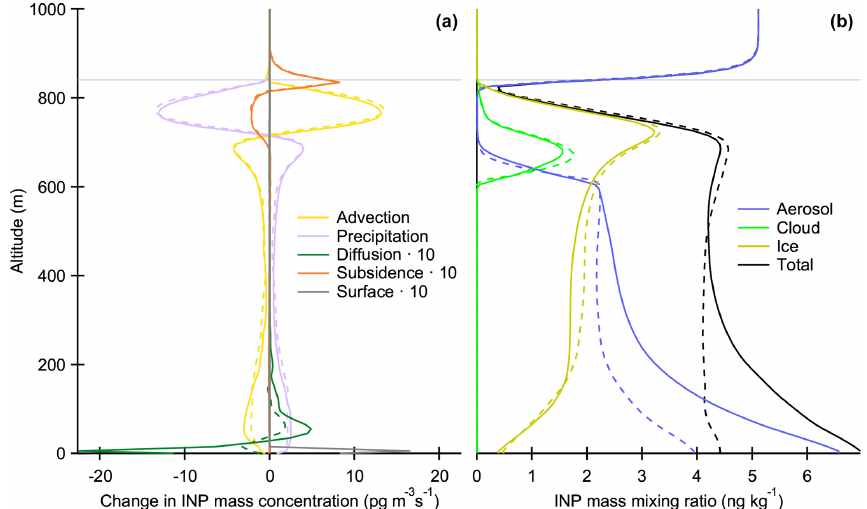
Figure 5. Horizontally averaged profiles of the main processes acting on INP mass concentrations from simulations with (solid lines) and without (dashed lines) marine INP emissions (high background INP concentration). Diffusion, subsidence, and surface flux contribution are multiplied by a factor of 10 for clarity. Corresponding INP mass concentrations in aerosol, cloud, ice and in total are shown in panel (b) . The profiles are 1h averages over the eighth simulation hour. Cloud top height (840m) is indicated by the horizontal lines.